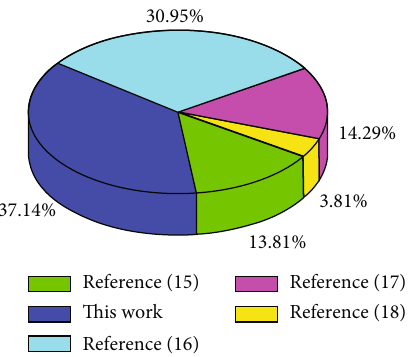
Figure 9: Fan chart of accuracy of di ff erent public opinion training data test